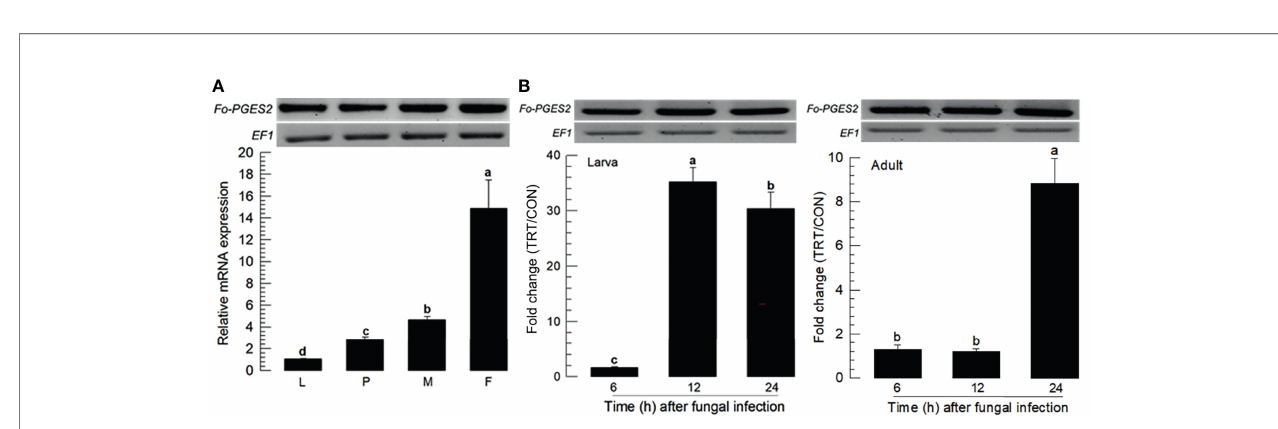
FIGURE 3 | Identi fi cation and molecular characterization of two secretory phospholipase A 2 (sPLA 2 ) and two calcium independent PLA 2 (iPLA 2 ) genes in F. occidentalis named as Fo-sPLA 2 A , Fo-sPLA 2 B , Fo-iPLA 2 A , and Fo-iPLA 2 B . (A) Domain andphylogenyanalyses of Fo-PLA 2 s. Phylogeneticanalysis was performed using MEGA6.06. Bootstrapping values were obtained with 1,000 repetitionsto support branchingandclustering. Aminoacid sequences of PLA 2 s were retrievedfromGenBank with accession numbers shownin Supplementary Table S2 . Four Fo-PLA 2 s are denoted inthe phylogenytree by rectangular boxes. Domains were predicted using Prosite (https://prosite.expasy.org/)and SMART protein(http://smart.embl-heidelberg.de/). Different colored boxes andshapes represent different regionsinthe domain. (B) Expression of Fo-PLA 2 s in different developmentalstages of larva ( ‘ L ’ ),pupa( ‘ P ’ ),male( ‘ M ’ ), andfemale ( ‘ F ’ ) adult. (C) Inducible expressions offour Fo-PLA 2 s ( Fo-sPLA 2 A , Fo-sPLA 2 B , Fo-iPLA 2 A , and Fo-iPLA 2 B ) in L2larvae or adults upon challenge with B.bassiana (1×10 6 conidia/mL) at different time points. RNA samples were collected from the whole body extracts of larvae (~100)oradults (~100) for each treatment. The expression of an endogenous gene, EF1 , con fi rms equal gel loadingand integrity of cDNA preparation.Each measurement was replicated three times. Fold changes are calculated byratios of expression levelsofimmune-challenges ( ‘ TRT ’ ) over naïve ( ‘ CON ’ ) thrips. (D) Enzyme activity ofFo-sPLA 2 . Forinhibitorassay, protein samples were collected from the wholebodyextracts of larvae (~100)for each treatment. Protein samples were incubated with p -bromophenacyl bromide(BPB) or methylarachidonyl fl uorophosphate (MAFP) in vitro for 30 min.To check enzyme activity innaïve condition, the whole body extracts of larvae (~100),pupae (~100), andadults (~100) were used. (E) Fo-sPLA 2 enzyme activity after challenge with B.bassiana (1×10 6 conidia/mL) at different time points. Protein samples were collected fromthe wholebody extracts oflarvae (~100) or adults (~100) for each treatment. Each treatment was replicated